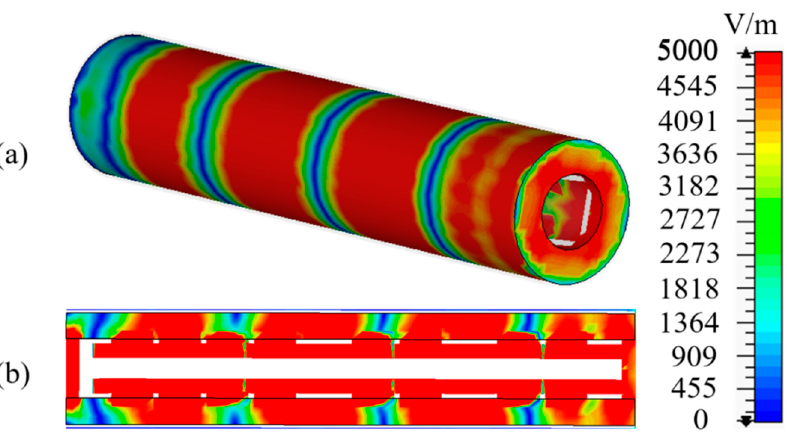
Figure 8. Electric field distribution of optimized structure: ( a ) three-dimensional electric field distribution, ( b ) two-dimensional electric field distribution cut along the coaxial radiator.